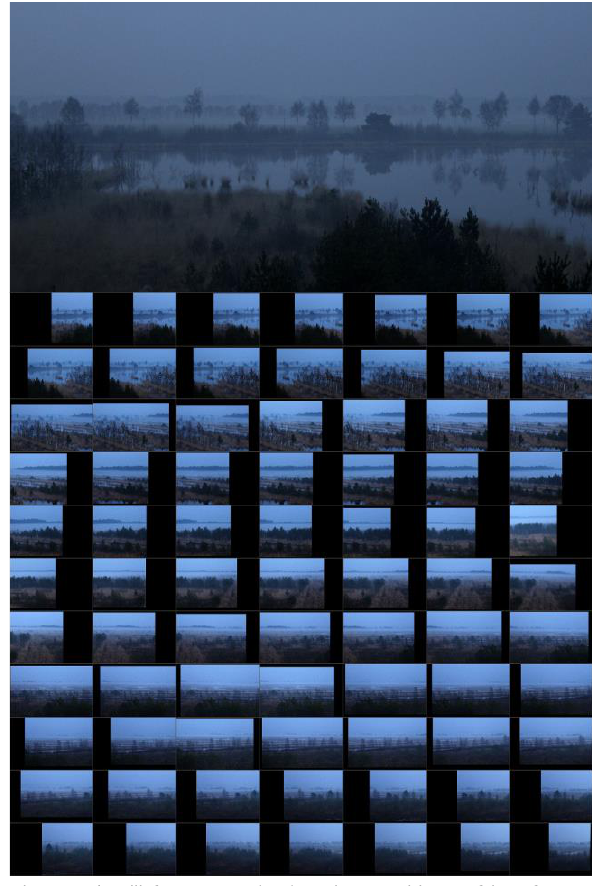
Figure 5 | Still from Moor (top) and assemblage of key frames (bottom) showing the relative